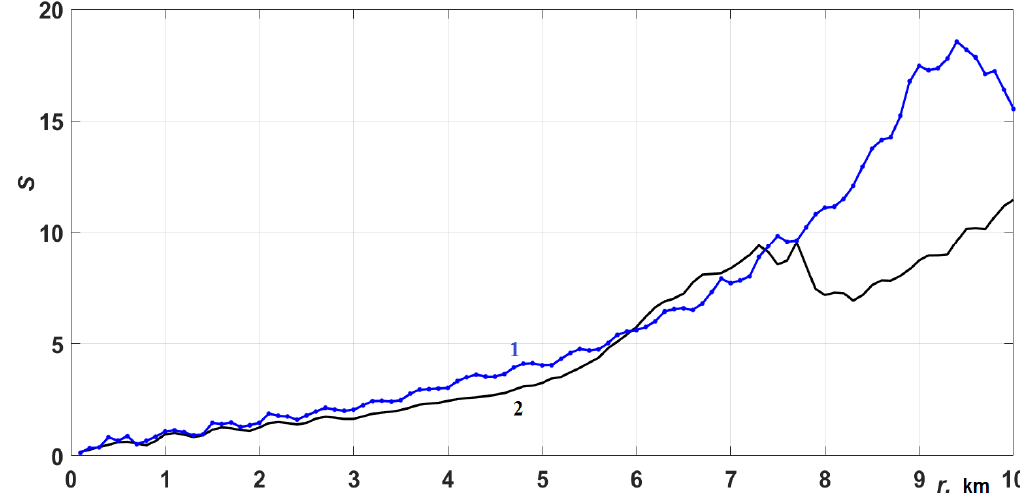
Figure 5. Development of intensity fluctuations S in stochastic waveguides according to the OW solution (2)–(5). H = 30 m, z = z 0 = 14 m. Marker curve 1 corresponds to the waveguide with random c 1 ( r ). Solid black curve 2 corresponds to the waveguide with random c 1 ( z , r ).